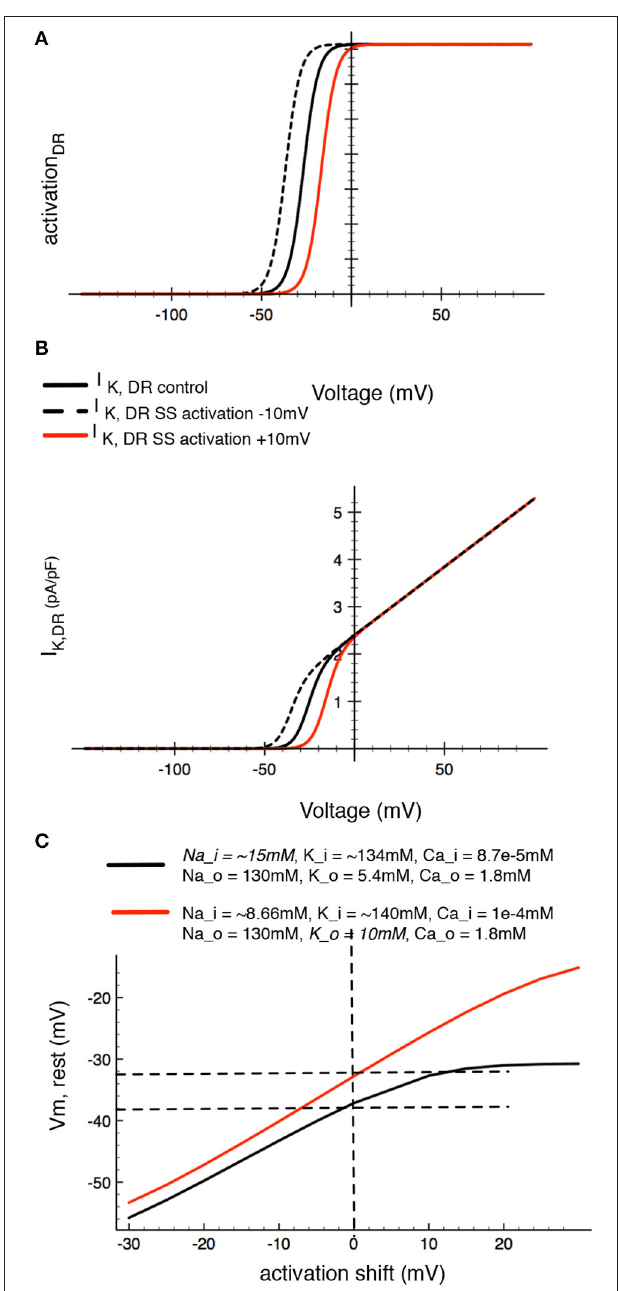
FIGURE 10 | Demonstration of the effects of in silico changes in the voltage-dependence for activation of the delayed rectifier K + current, I K DR , − Panels (A,B) , illustrate the altered activation curves and I-V relationships, respectively. Panel (A) shows the derived activation curve for I K DR (black line) − at baseline and after shifting its midpoint 10mV to begin an analysis of the ± effects of changes in surface potential on chondrocyte E m . Panel (B) shows the (black line computed chondrocyte I–V curves for I K DR at baseline and − after the activation of I K DR is shifted ± 10mV. Panel (C) shows the − corresponding changes in resting membrane potential in the baseline model and after [Na + ] i . The red line in (C) was computed assuming that intracellular [Na + ] i is 15mM. The resulting augmentation/stimulation of the Na + /K + pump provides an electrogenic outward current that can significantly hyperpolarize E m (see Discussion section) at all membrane